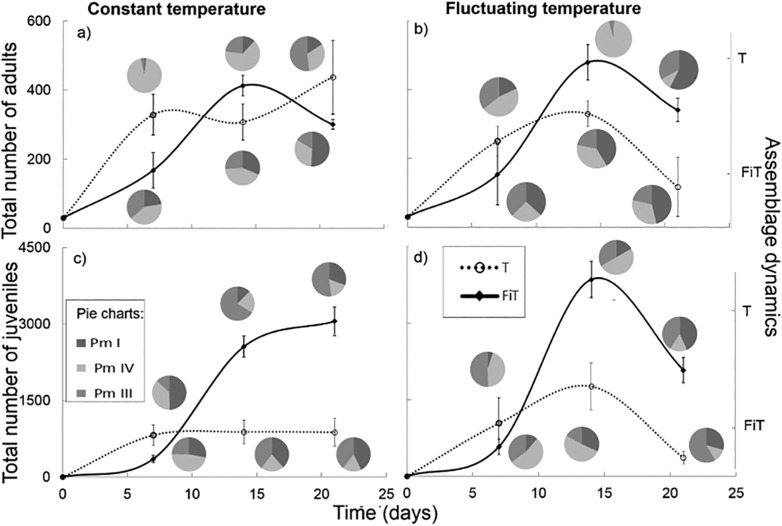
Total number of nematodes (adults: a + b, juveniles: c + d) over time in the different temperature treatments (constant temperature: a + c, fluctuating temperature: b + d) with assemblage dynamics at the different sampling times (three pie charts correspond with following time moments: 7, 14 and 21 days): upper pie charts for the T treatment (Pm I, Pm IV and Pm III with interspecific interactions), lower pie charts are the dynamics in the FiT treatment (Pm I, Pm IV and Pm III without interspecific interactions).